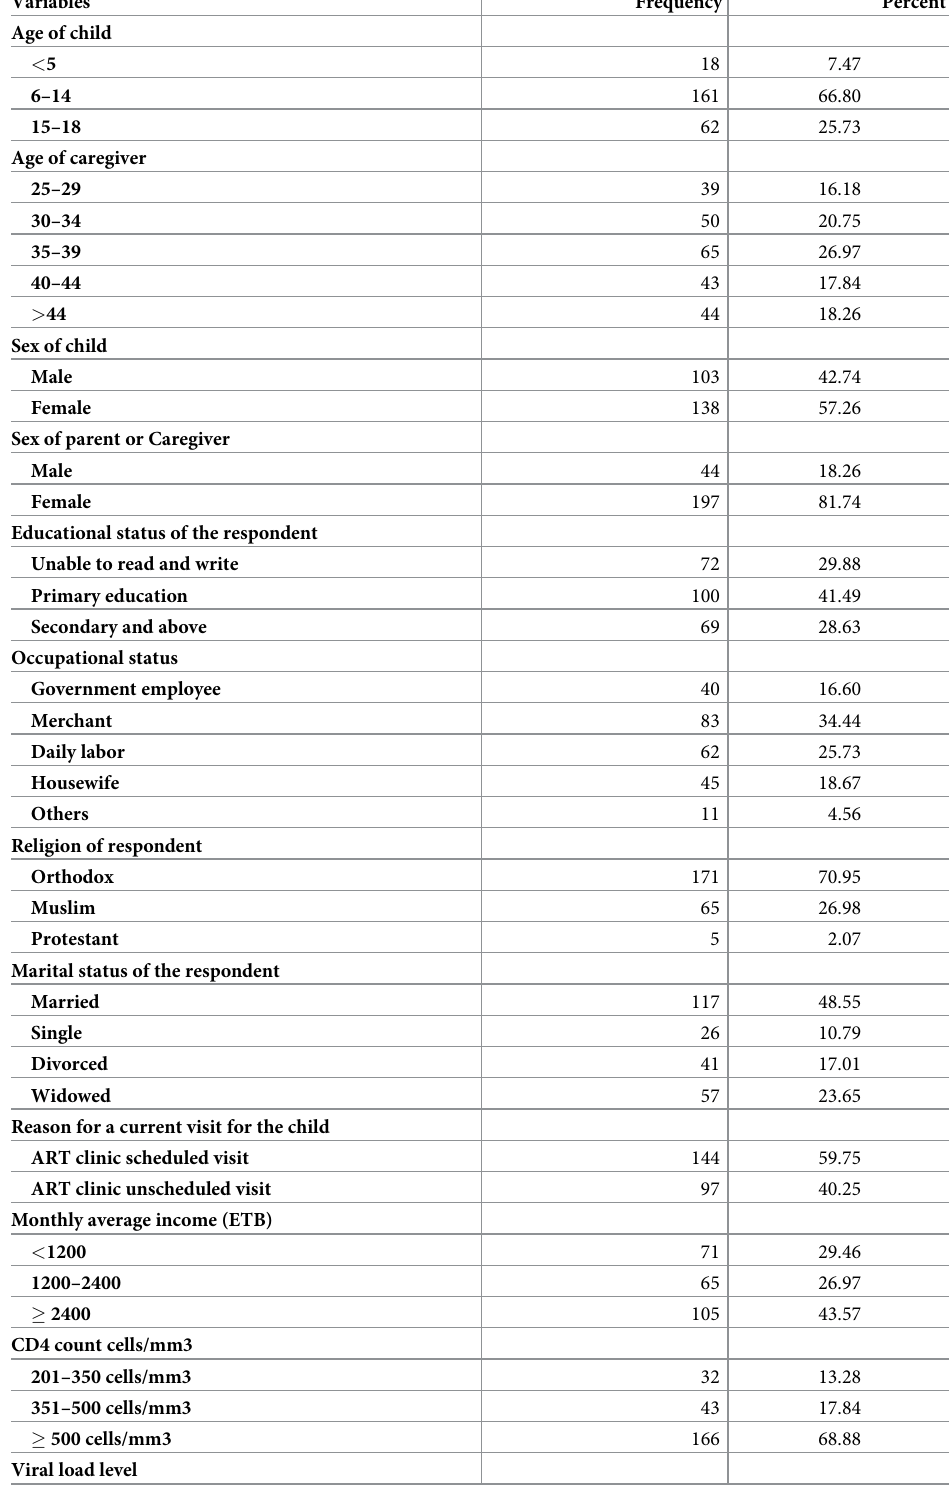
Table 4. Characteristics of a study participant in GCAHCs, April